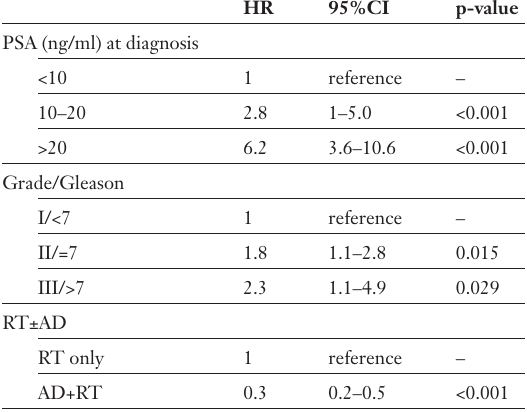
Factors selected by the Cox regression analysis for 381 pa- tients with complete data to correlate with overall survival. Factors selected by the Cox regression analysis for 381 pa- tients with complete data to correlate with biochemical disease- free survival.